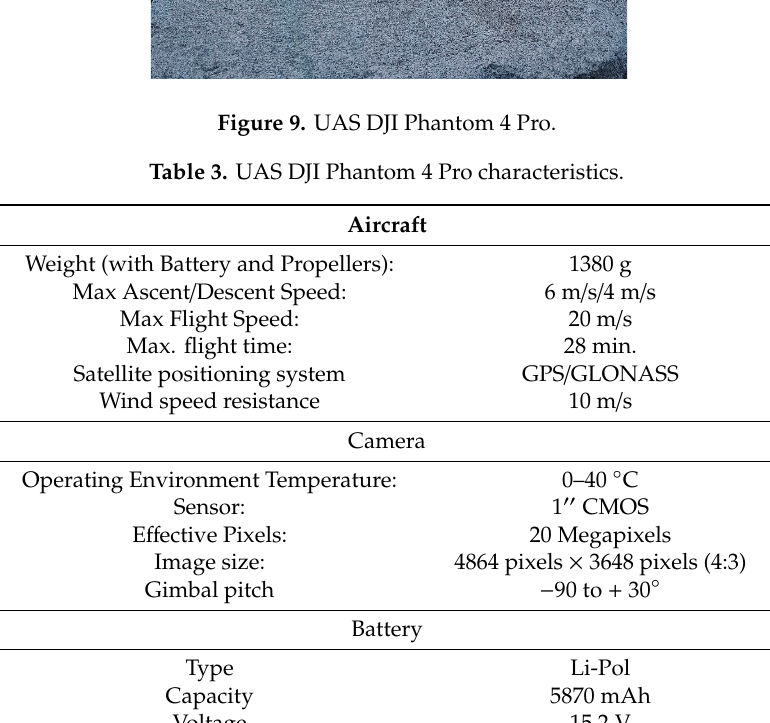
Figure 9. UAS DJI Phantom 4 Pro.